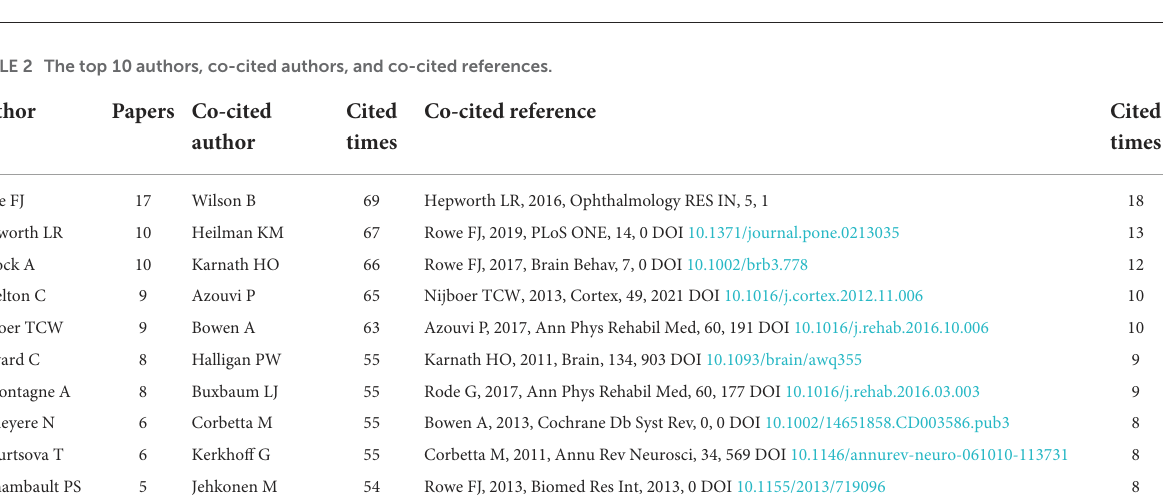
FIGURE8 The number of articles, open-access papers, citations, H-index, and citations per paper of the top 15 institutions.